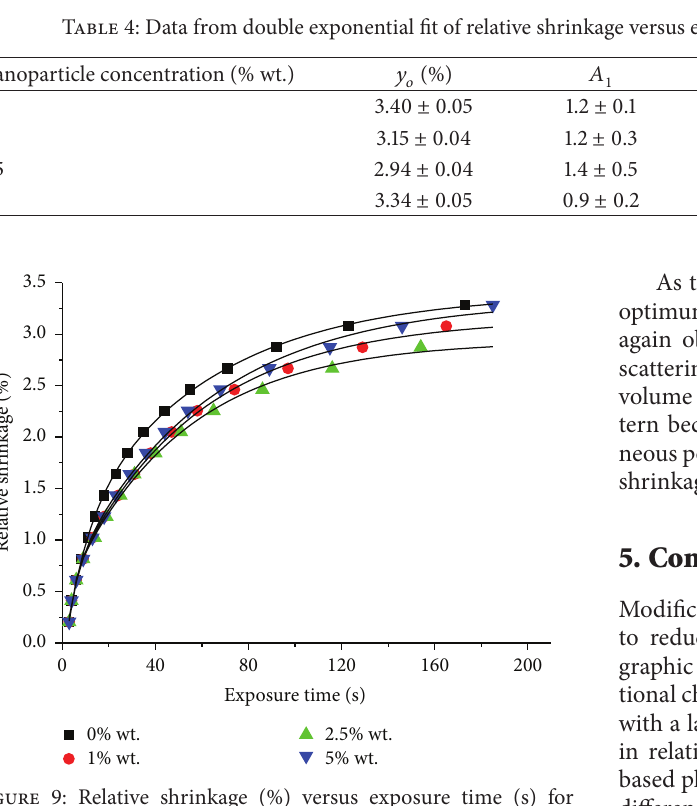
Figure 9: Relative shrinkage (%) versus exposure time (s) for gratings recorded in 160 𝜇 m thick AA photopolymer layers with BEA concentrations of 0, 1, 2.5, and 5%